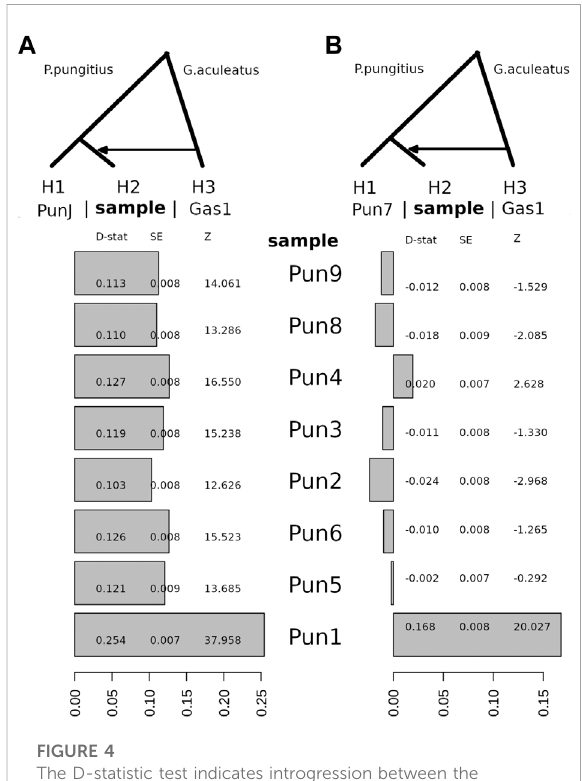
FIGURE 4 The D-statistic test indicates introgression between the White Sea three-spined stickleback, G. aculeatus specimen (Gas1) and all of the White Sea nine-spined stickleback P. pungitius specimens with respect to the Japanese nine-spined stickleback specimen (A) and the White Sea nine-spined stickleback specimen (B) . Compared with the Japanese nine- spined stickleback, all of the White Sea nine-spined stickleback specimens have considerable introgression levels from three- spined stickleback. D-stat, the result of D-statistic test; SE, standard error; Z,